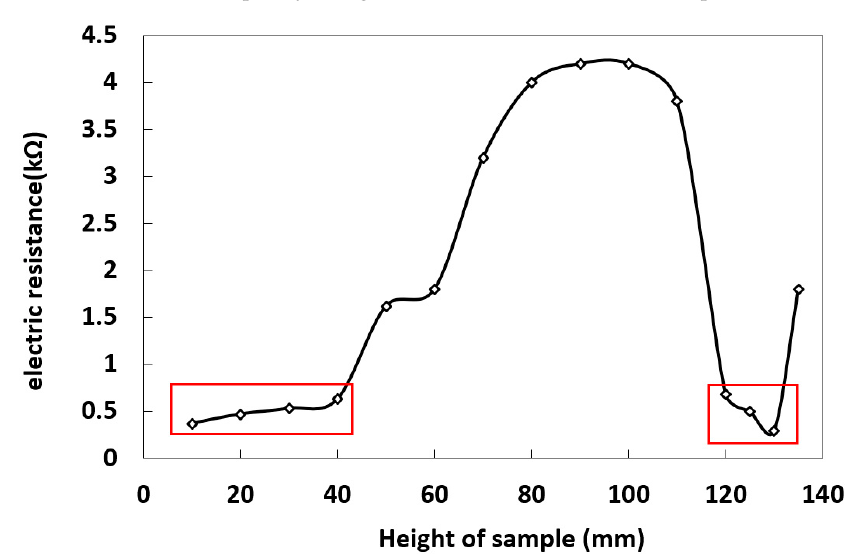
Figure 4. Solution resistance at different heights.